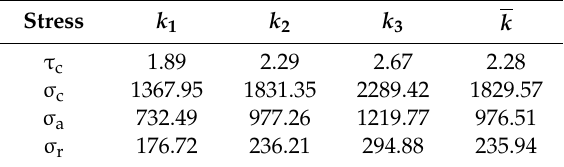
Figure 12. Variation on capsule surfaces with discharge. Figure 12. variation on capsule surfaces with discharge. Table 2. Between stress-change rate of τ c , σ c , σ a and σ r , and unit Table 2. between stress-change rate of τ c , σ c , σ a and σ r , and unit flow.